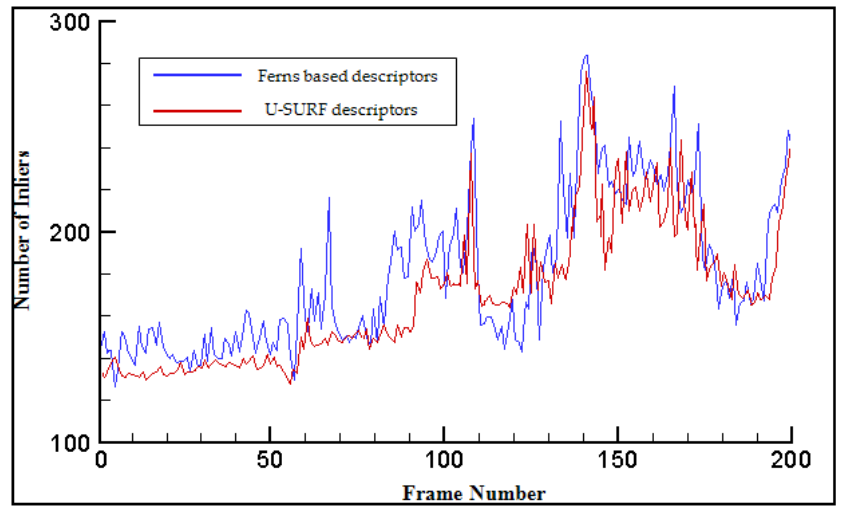
Figure 10. Comparing of matching performance between U-SURF and ferns descriptors.